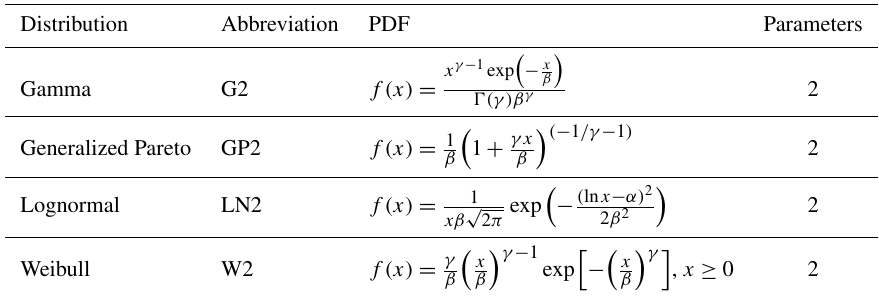
Table 3. Theoretical probability distributions presented on the L-Cv vs. L-skew L-moment